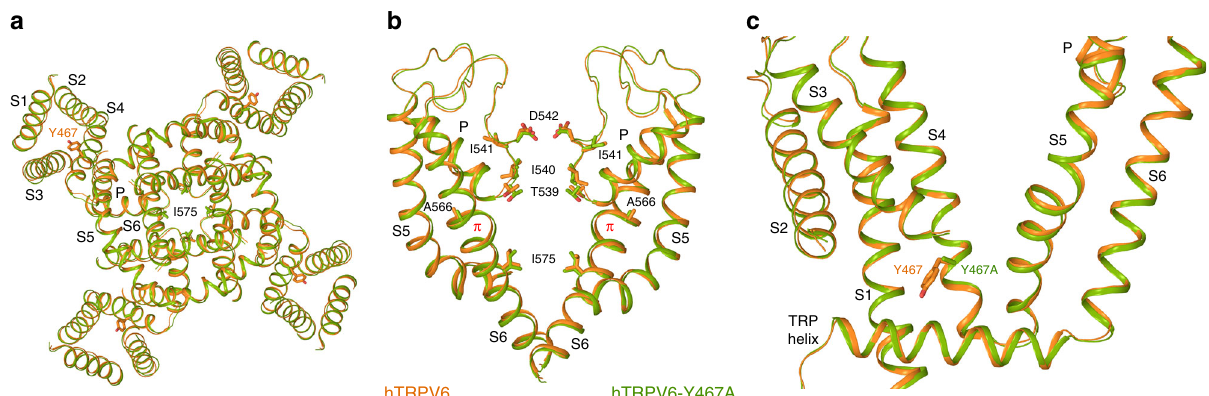
Fig. 7 Comparison of hTRPV6 and hTRPV6-Y467A cryo-EM structures. a – c Superimposed are the transmembrane domain viewed intracellularly ( a ) and the pore-forming region with the front and back subunits omitted for clarity ( b ), and the transmembrane domain of a single subunit ( c ) viewed parallel to the membrane for the cryo-EM structures of hTRPV6 (orange, PDB ID: 6BO8) and hTRPV6-Y467A (green). Residues contributing to the selectivity fi lter and gating as well as Y467 and Y467A are shown as sticks. The local π helical conformations of S6 associated with the open channel are indicated (red labels)